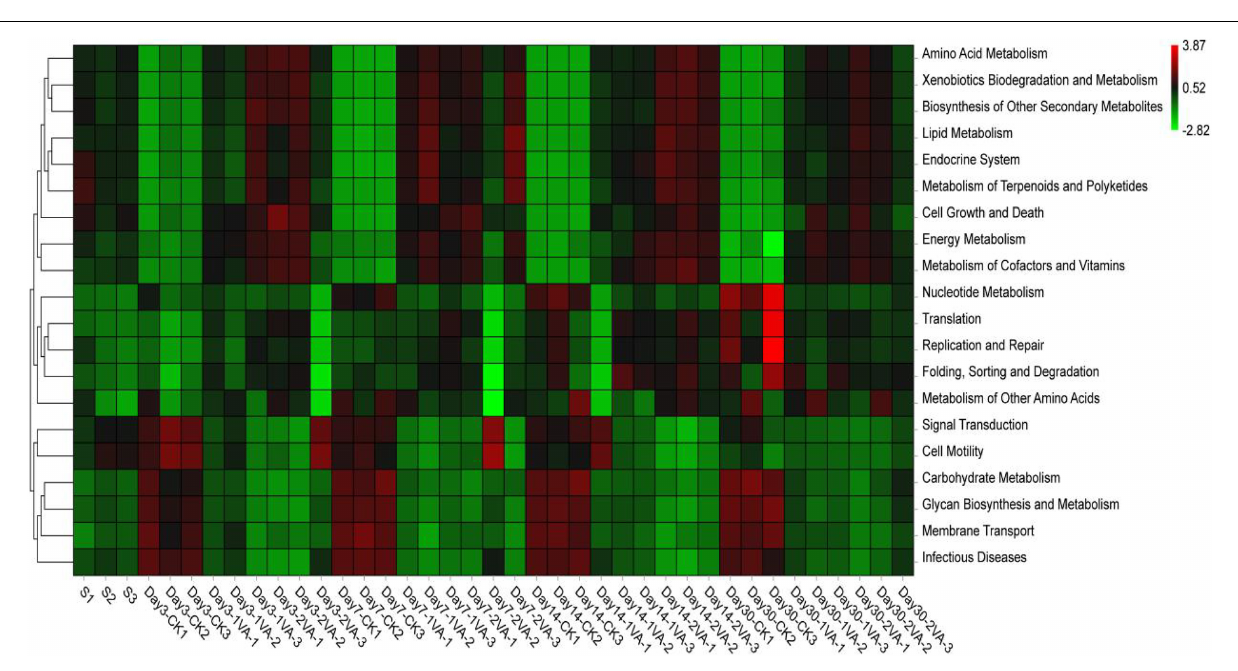
FIGURE 5 | Heat map of 16S rRNA gene-predicted functional profiles of stylo silage ensiled with the addition of vanillic acid (S: raw material, i.e., fresh stylo, CK: blank control, 1 and 2%: addition of 1 or 2% vanillic